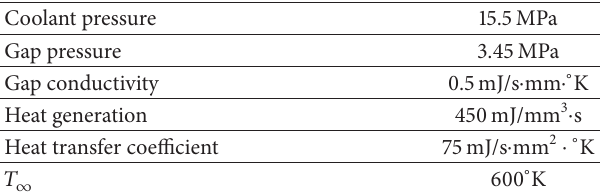
Figure 8: Solid nuclear fuel model and boundary conditions. Table 1: Applied condition.